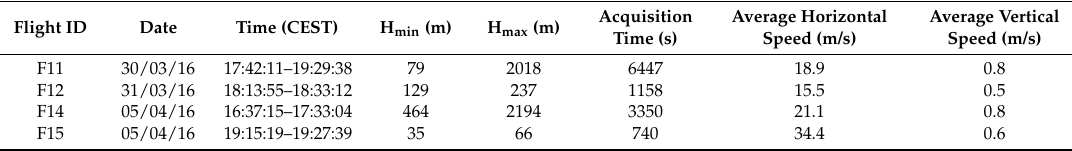
Table 1. Main parameters of the four flights. H min and H max (minimum and maximum height) refer to the flight height above sea level calculated by averaging the measurements of the different sensors. Average horizontal and vertical speeds are calculated using the data from GPSABC.